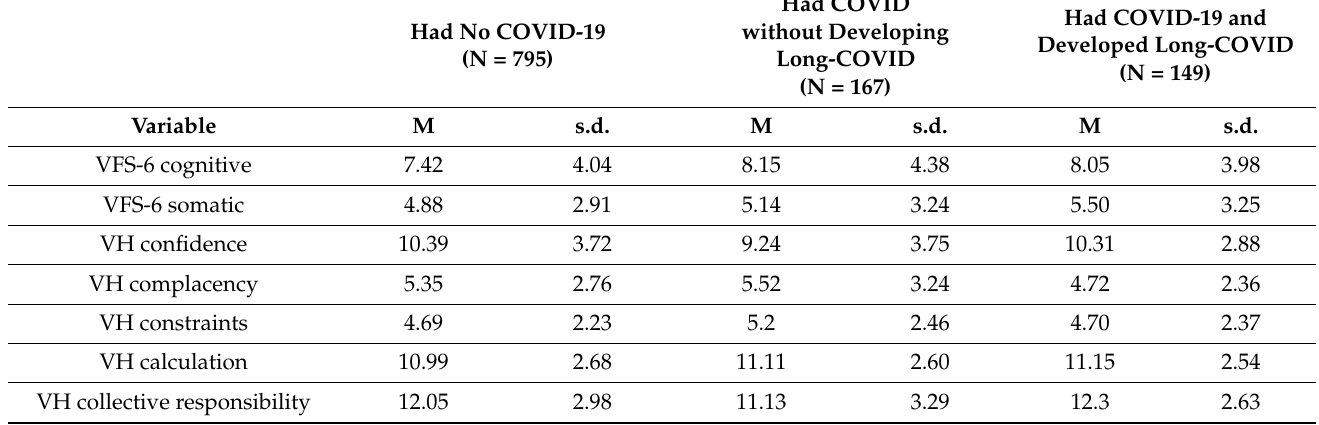
Table 1. Descriptive statistics.